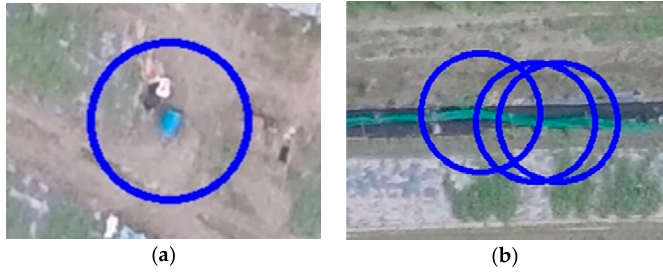
Figure 23. The other reporting targets: ( a ) A blue bucket and ( b ) green nets.